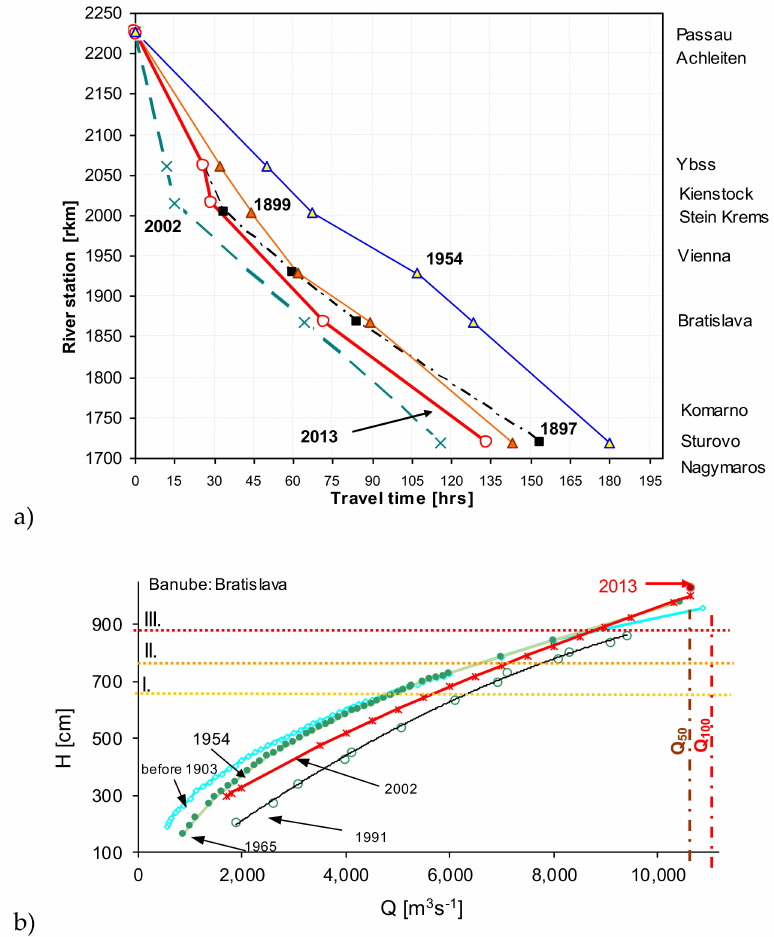
Figure 10. ( a ) Travel times of selected floods, and ( b ) comparison of rating curves of the Danube River at Bratislava (red point: maximum hydrological values of the flood in June